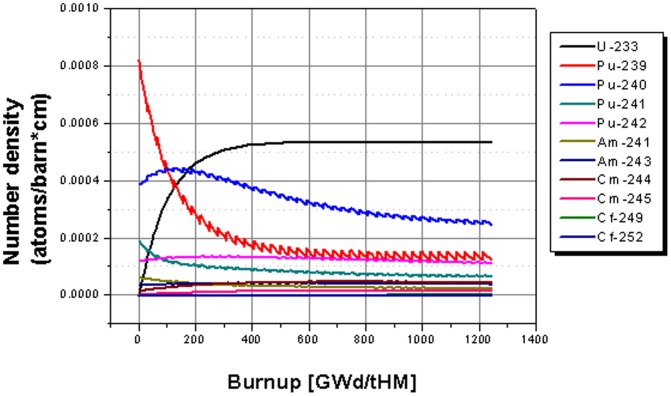
Evolution of the isotope inventory for the case based on Th-232 fertile material.